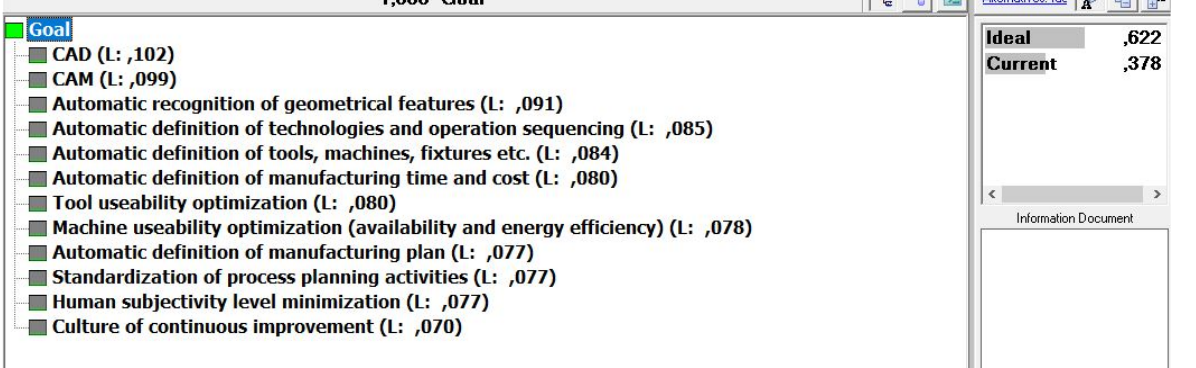
Figure 4. Readiness calculation model structuring in Expert Choice software.